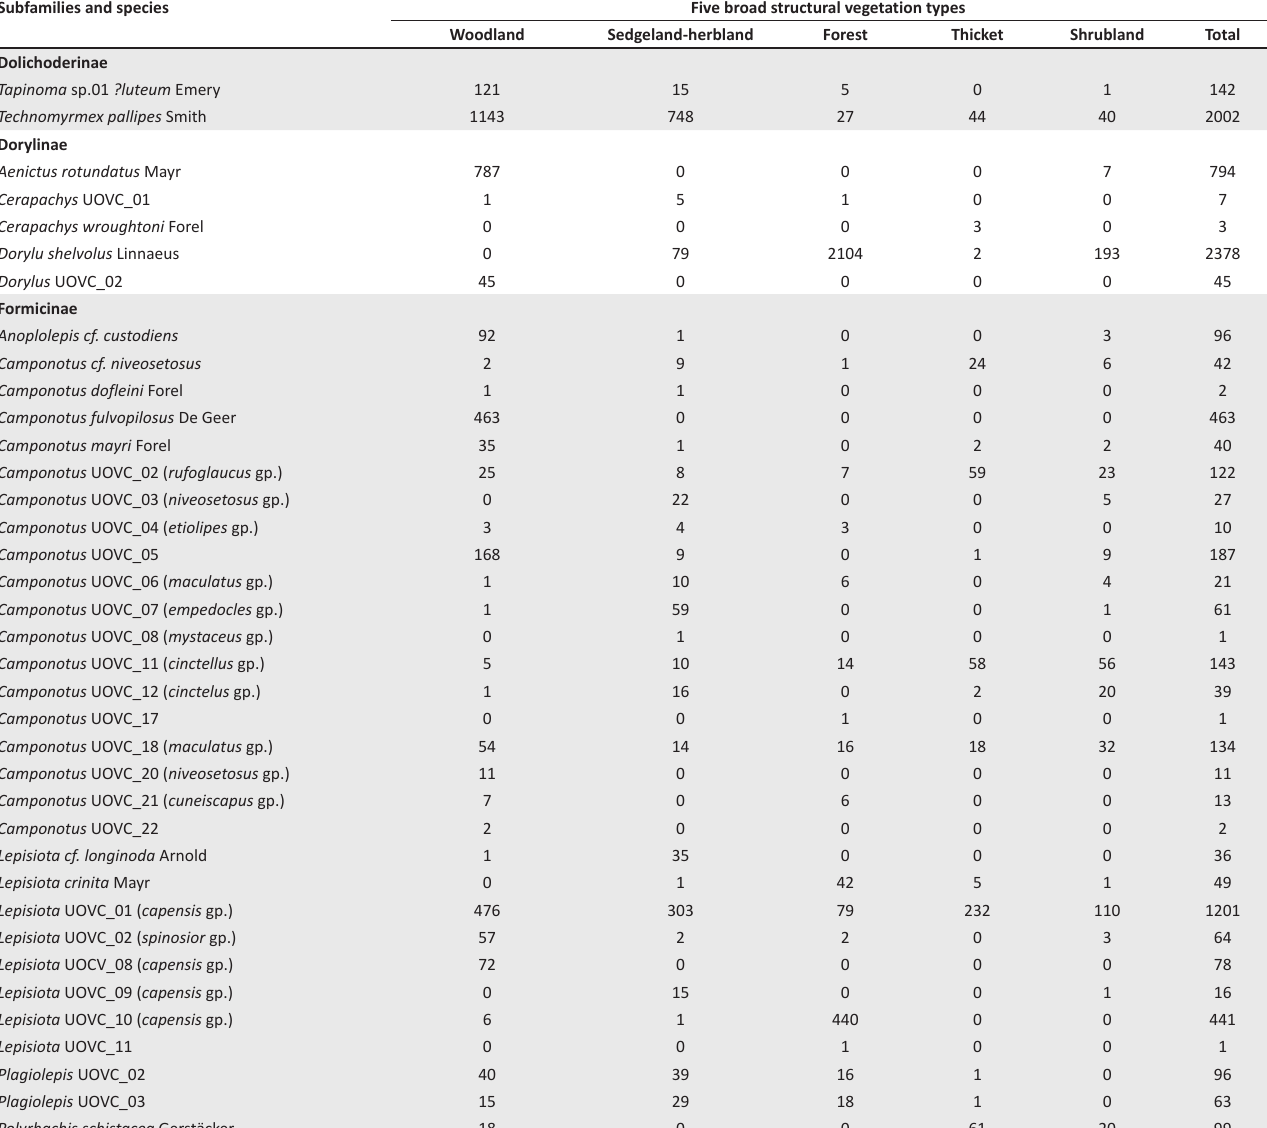
TABLE A2: Checklist of subfamilies and ant species collected during 13 surveys in different broad structural vegetation types across an elevational transect in the western Soutpansberg Mountain Range in South Africa. Subfamilies and